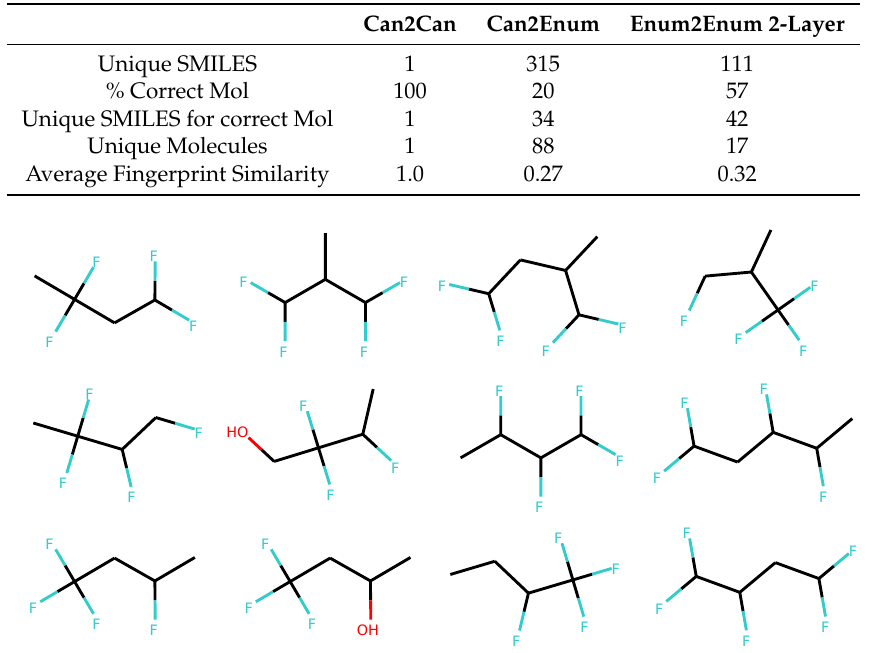
Figure 11. Examples of different sampled molecules using multinomial sampling with the decoder from the two layer LSTM model (enum2enum 2-layer). The one in the upper-left corner is the reference molecule used to encode the latent space